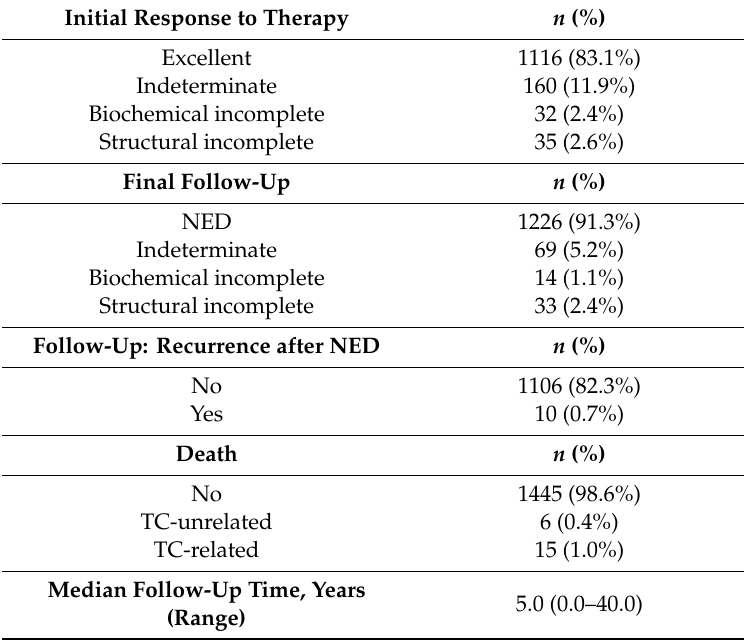
Table 2. Initial response to therapy and response at follow-up in the study group.